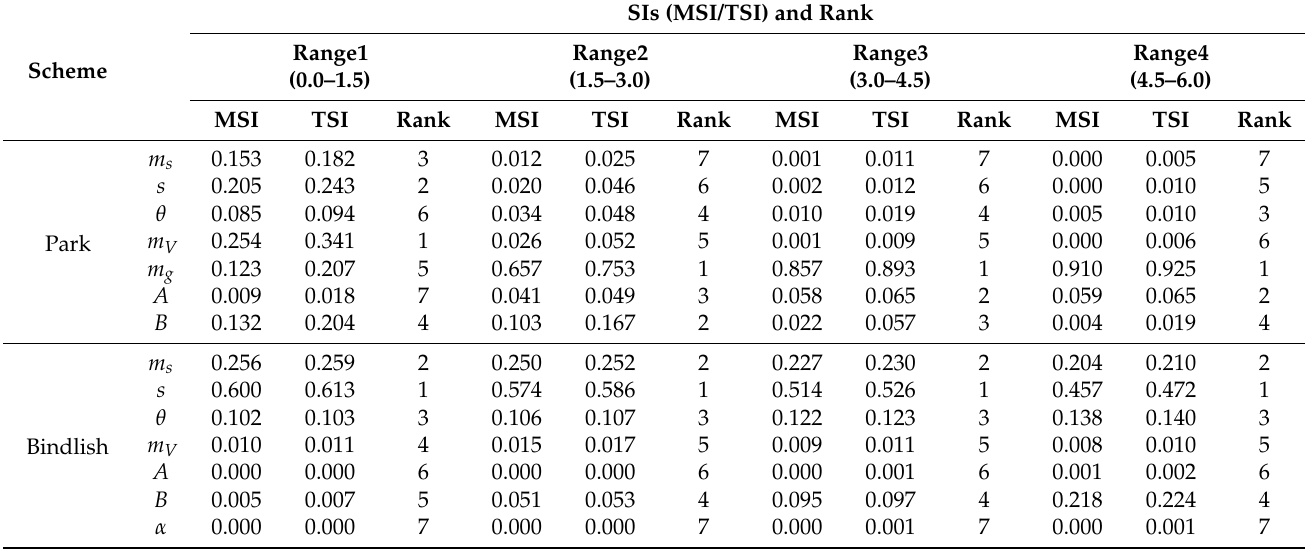
Table 2. Parameter SIs under different ranges of VWC (kg/m 2